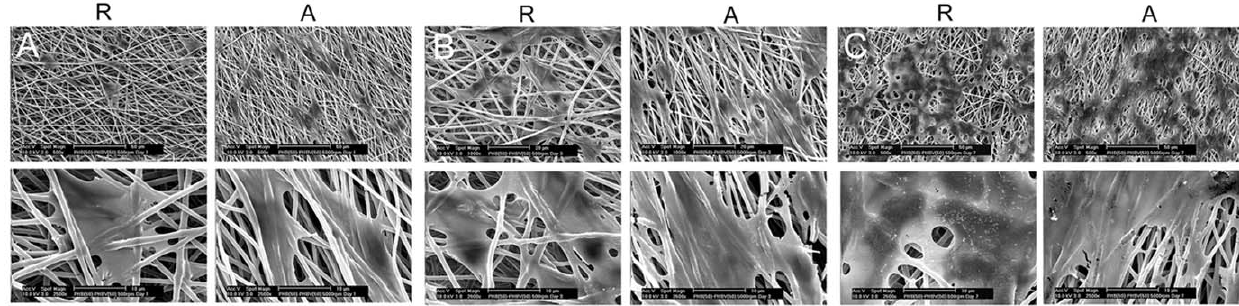
Figure 5. SEM images of SCs on PHB(50)/PHBV(50) random (R) and aligned (A) nanofibers. (A) 1 day, (B) 3 days, and (C) 7 days after cell seeding. Scale bars represent 50 m m for top and 10 m m for button pictures,